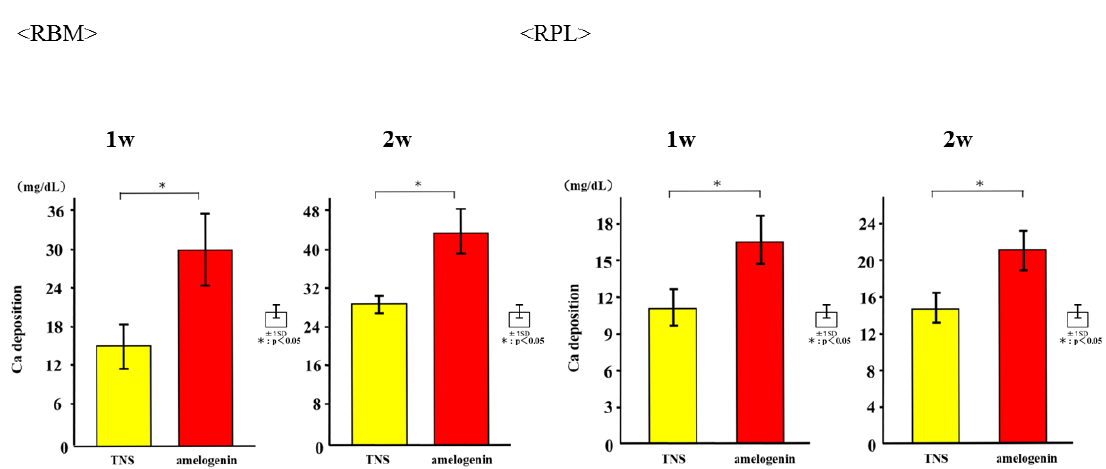
Figure 11. Ca deposition in test and control groups. * p < 0.05.